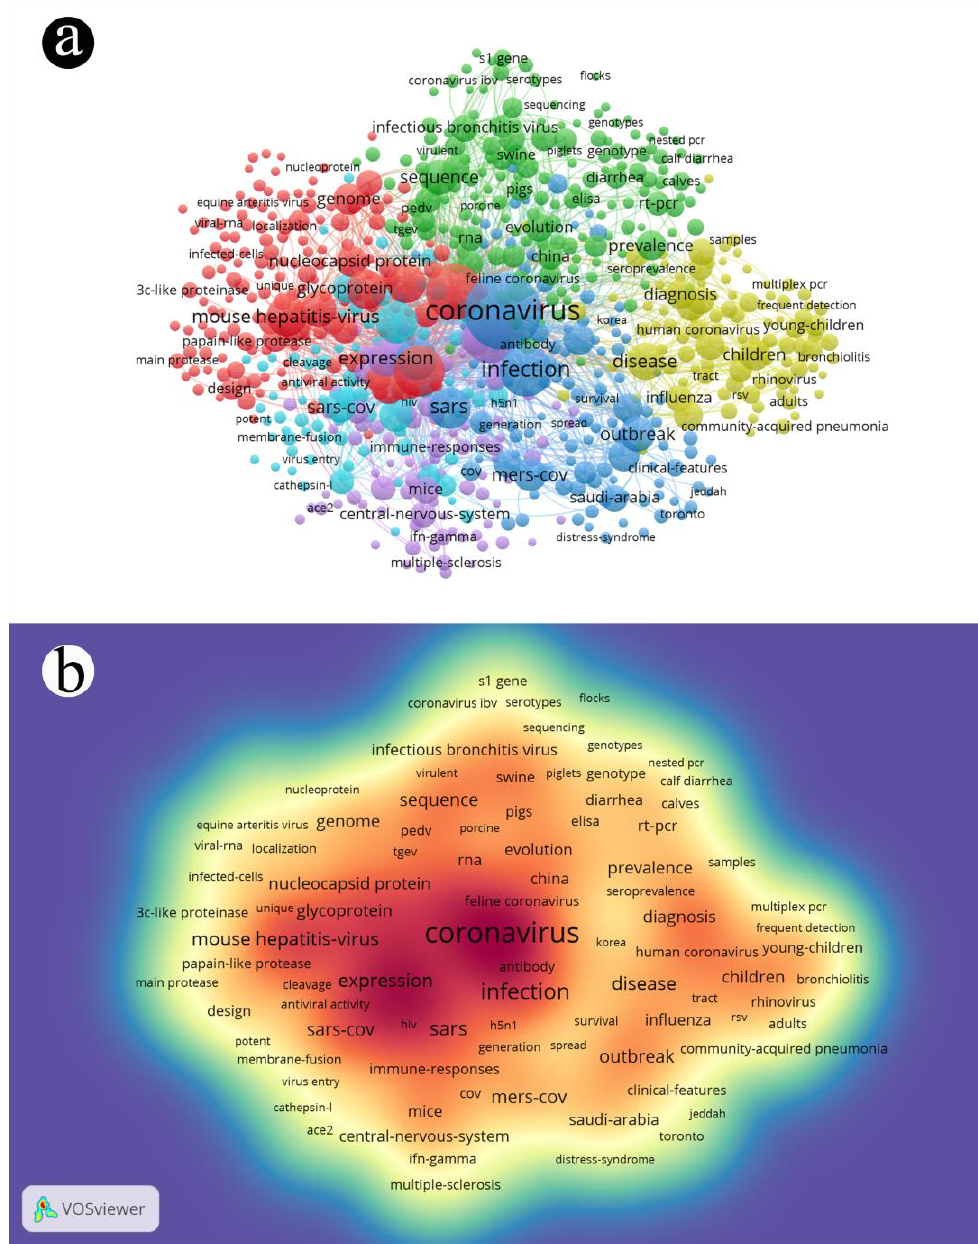
Figure 4. The visualization of keywords or terms used in coronavirus articles. ( a ) Different clusters and internal links between different terms contained in the sphere and lines; ( b ) density map of frequent terms indexed in Web of Science.